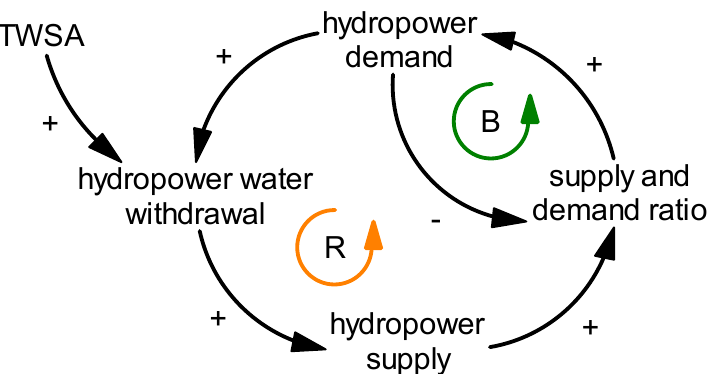
Figure 5. Causal loop diagram of supply and demand feedbacks for hydropower generation. The ‘+’ sign with the arrow indicates two variables changing in the same direction, and the ‘ − ’ sign indicates the opposite direction. Reinforcing loops (positive feedback, labeled as ‘R’), enhance the system to keep growing over time, amplifying the impact of the disturbance, whereas balancing loops (negative feedback, labeled as ‘B’) balance the system over time, negating the impact of the disturbance.